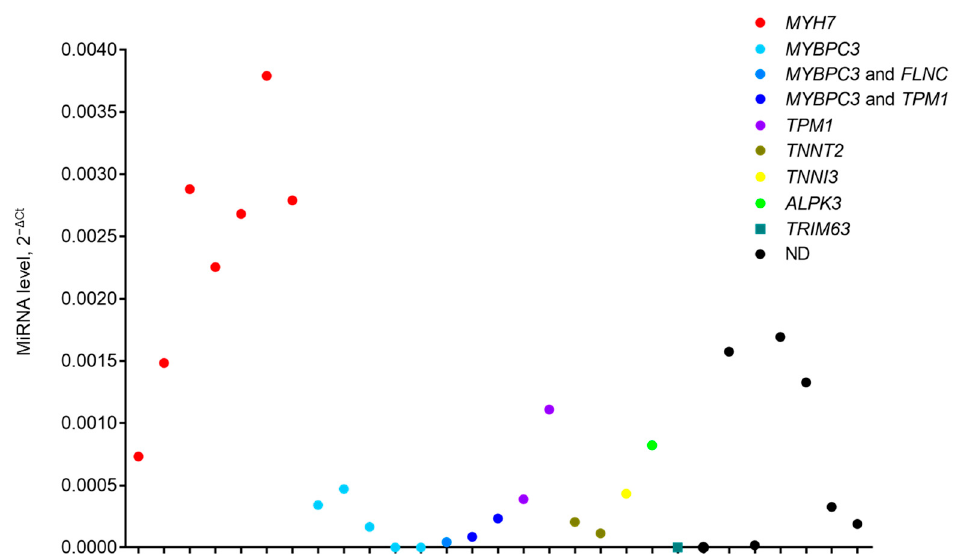
Figure 3. Level of circulating miR-499a-5p in each HCM patient depending on sequencing data of HCM-associated genes. ND—patients in whom mutations in sequenced genes were not determined. The comparison of miRNA levels between groups of patients showed significant dif- ferences; carriers of P/LP variants in the MYH7 gene were defined with significantly higher level of miR-499a-5p compared to carriers of mutations in the MYBPC3 gene (FC = 14.1; p = 0.0003) and to a combined group of carriers of variants in other genes and patients without identified mutations) (FC = 4.1; p = 0.0008) (Figure 4). It could be seen that in MYH7 variant carriers, the miR-499a-5p levels were also significantly higher than in con- trols (FC = 8.9; p < 0.0001). Conversely, the miR-499a-5p level in MYBPC3 variant carriers and in the mixed group of other patients did not differ from the controls (Figure 4).